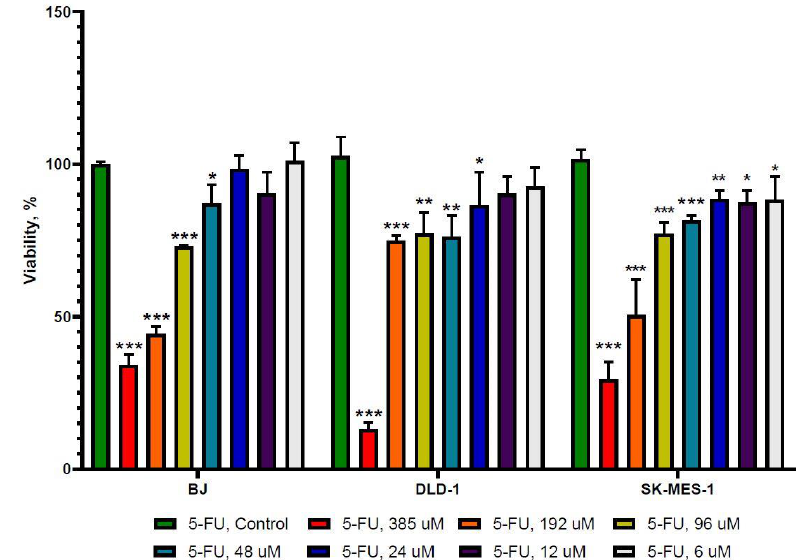
Figure 1. The viability rate analysis of 5-fluorouracil (5-FU) treatment. 5-FU inhibited cell growth in a dose-dependent manner in the case of normal fibroblasts (BJ), colorectal adenocarcinoma (DLD-1), and lung squamous adenocarcinoma (SK-MES-1) cells, with similar IC 50 , when incubated for 24 h (6, 12, 24, 48, 96, 192, and 385 µ M 5-FU). The results with p < 0.05 were considered statistically significant (* p < 0.05, ** p < 0.01, and *** p < 0.001). Molecules 2020 , 25 , x